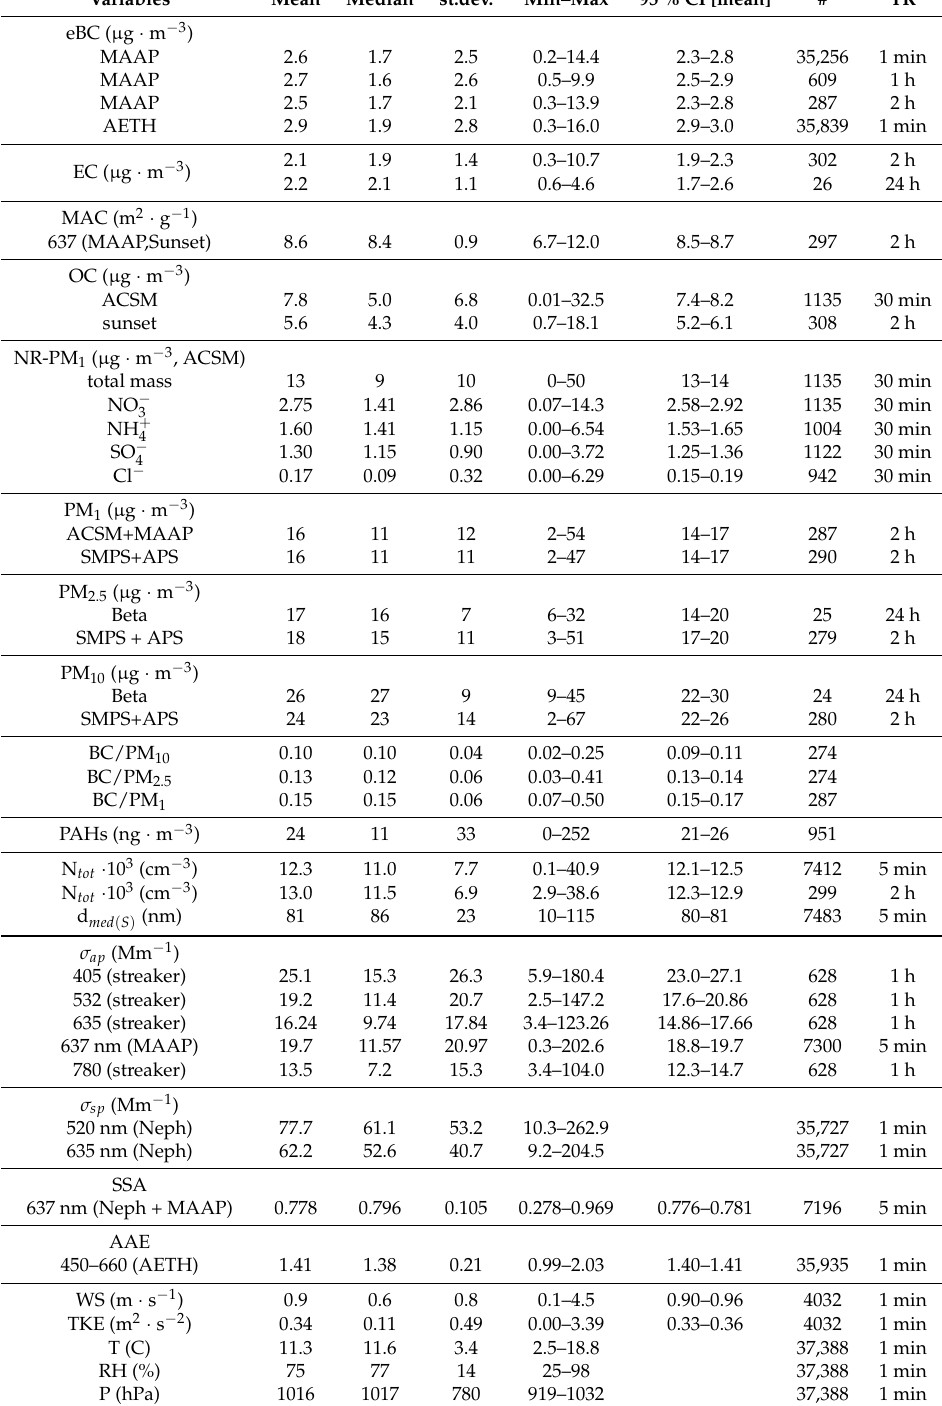
Table 2. Statistical summary of variables acquired from 16:00 2 February to 10:00 28 February 2017. Data are mean, median, standard deviation, minimum and maximum, 95% confidence interval (lower–upper), number of datapoints (#), and time resolution of data used to calculate the statistics (TR). Variables Mean